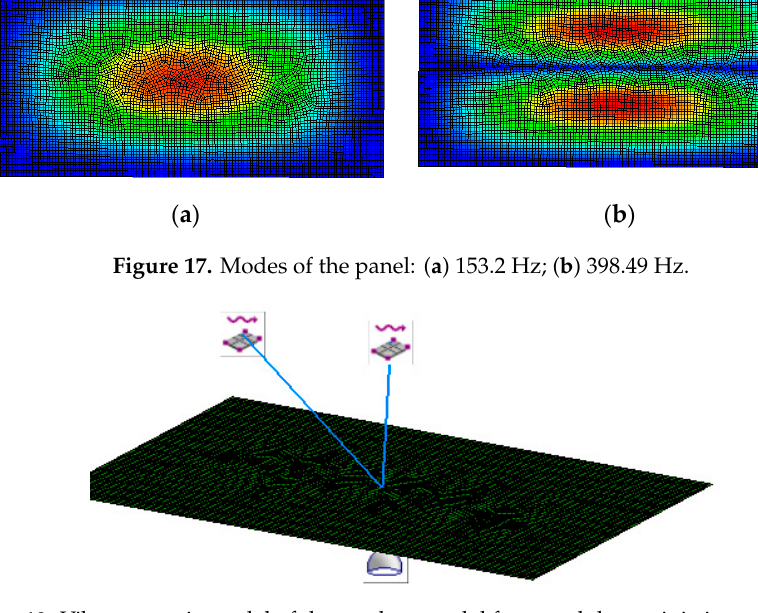
Figure 18. Vibro-acoustic model of the random modal force and deterministic modal force.